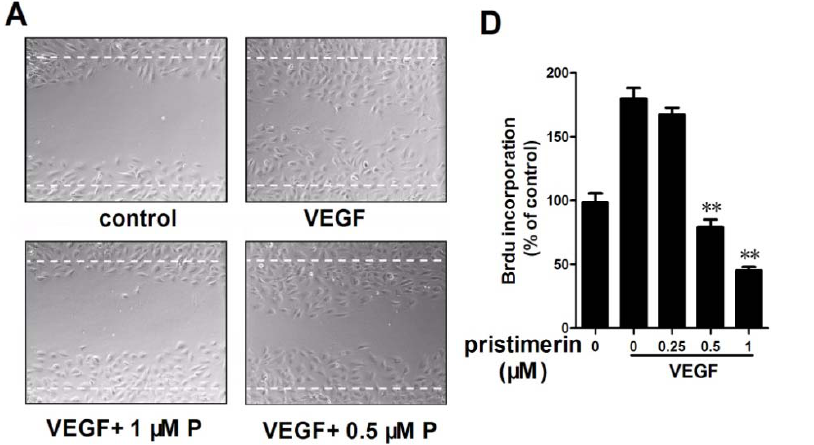
Figure 4. Pristimerin inhibits VEGF-induced chemotactic motility, capillary-structure formation and proliferation of endothelial cells. ( A ) pristimerin inhibited HUVEC migration. HUVECs were scratched by pipette and treated with or without 10 ng/mL VEGF and pristimerin(magnification, ×100). P, pristimerin; ( B ) Effect of pristimerin on VEGF-stimulated HUVECs migration in transwell assay. HUVECs were seeded in the upper chamber of a Transwell and treated with different concentrations of pristimerin. The bottom chamber was filled with ECGM supplemented with VEGF. After 8 h, the migrated cells were quantified by manual counting. (magnification, ×100). P, pristimerin; ( C ) pristimerin inhibits VEGF-induced capillary-structure formation of endothelial cells. HUVECs were placed in 96-well plates coated with Matrigel (2.0 × 10 4 cells/well). After 6 h, tubular structures were photographed (magnification, ×100). P, pristimerin; ( D ) pristimerin inhibited the VEGF-induced cell proliferation of HUVECs. Columns, mean; bars, SD. ** p < 0.01 versus VEGF